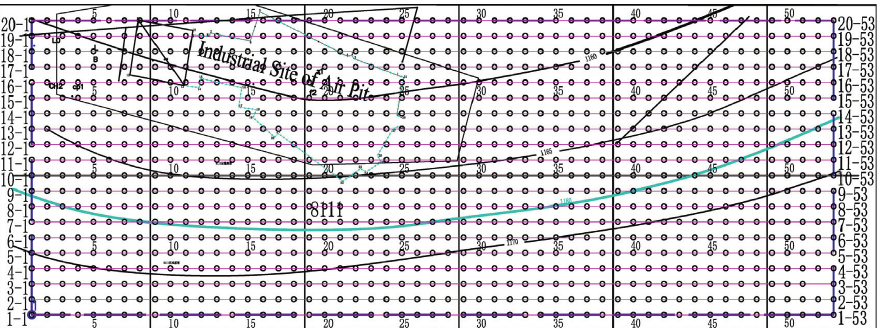
Figure 11: Schematic diagram of TEM line layout.